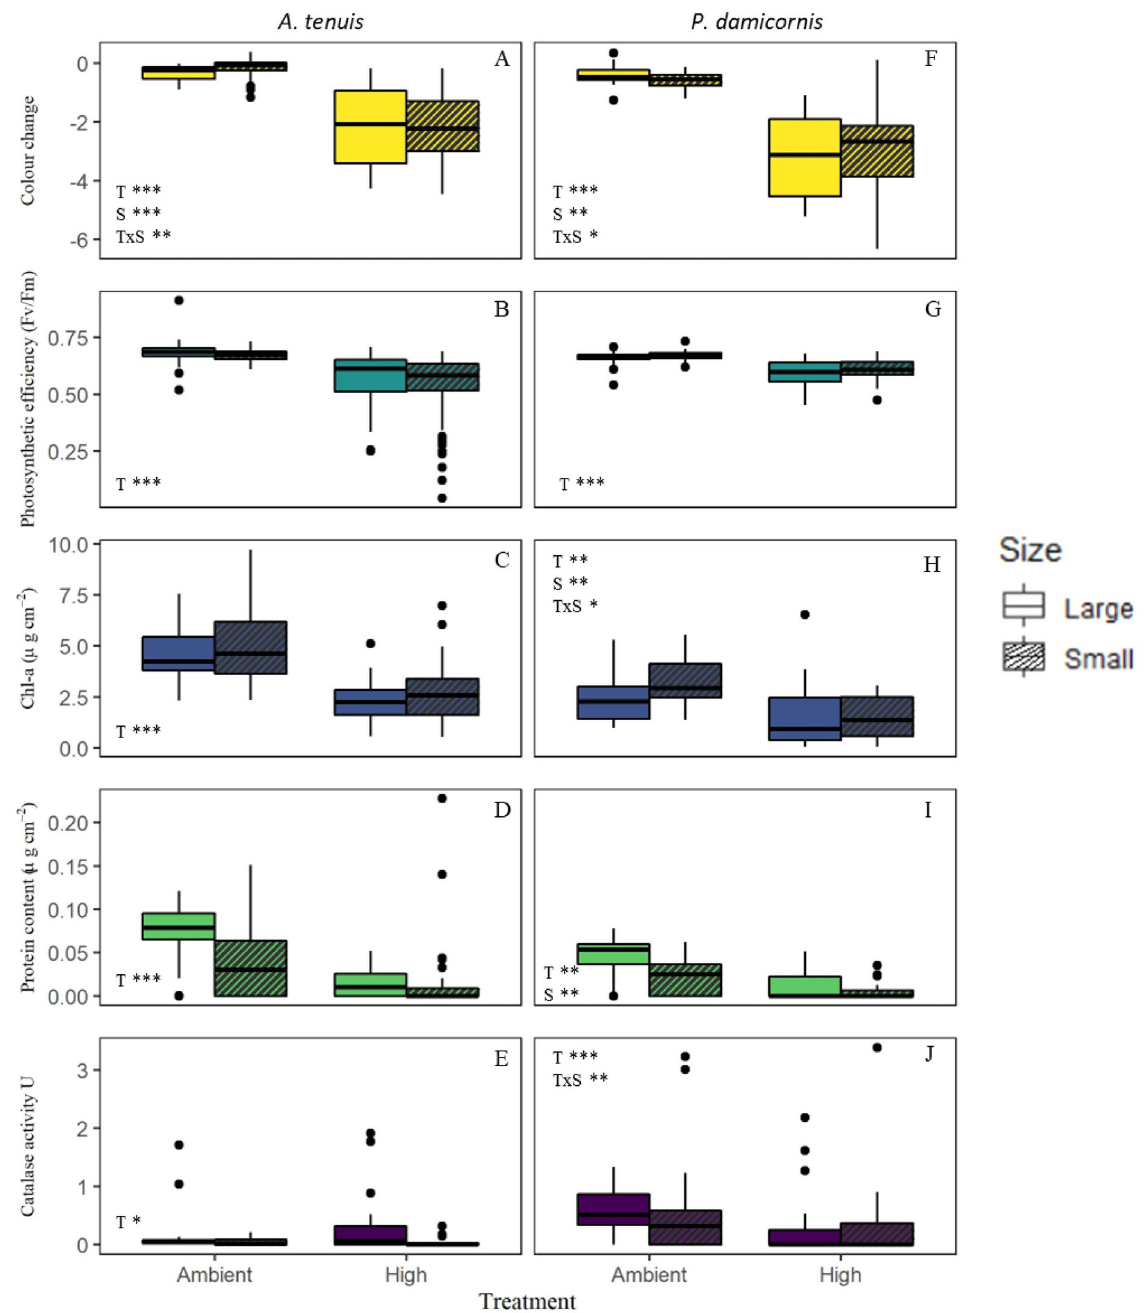
Figure 1. Physiological responses of large (full) and small (hatched) coral fragments to temperature treatment in A. tenuis (left panels) and P. damicornis (right panels). Bold line inside boxes shows the median, boxes indicate the interquartile range and dots represent data outliers. Significant effects are indicated for treatment (T), size (S) and their interaction (T × S) by asterisk where * p < 0.05, ** p < 0.005, *** p <